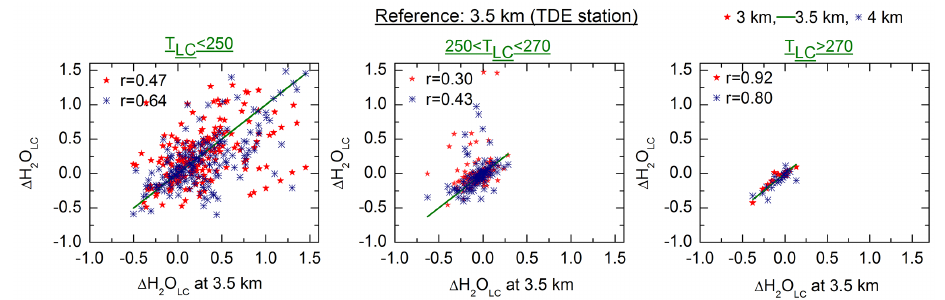
Figure C2. A 3-year (2012–2014) analysis of the uncertainty in the vertical resolution of the model using TDE as reference station. The correlation between (cid:49) H 2 O = log [ H 2 O (cid:48) ] − log [ H 2 O LC ] at 3500m with 3000 and 4000m respectively, is t = 0